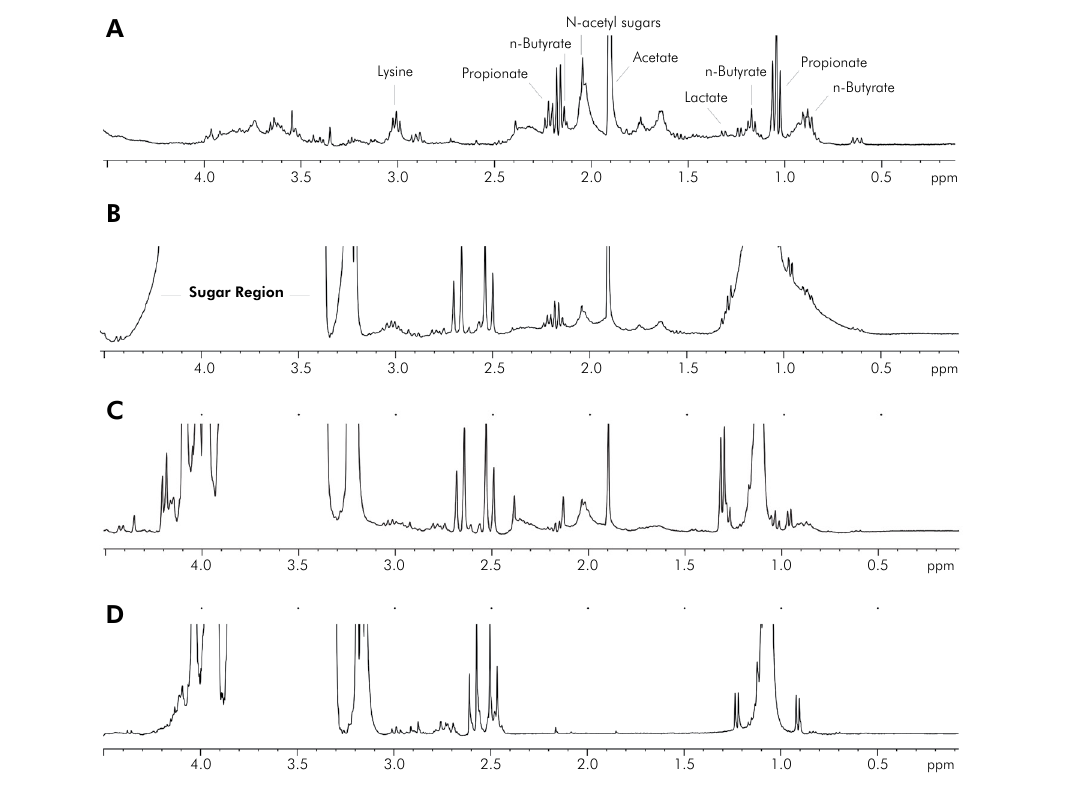
Figure 1. Representative 1 H NMR spectra of whole saliva before and after the administration of antihistamine syrup or pill mixture (0–4.5 ppm). A: Spectrum of whole saliva; B: Spectrum with in vitro syrup mixture; C: Spectrum after in vivo syrup experiment (rinse); D: Spectrum with in vitro pill suspension.